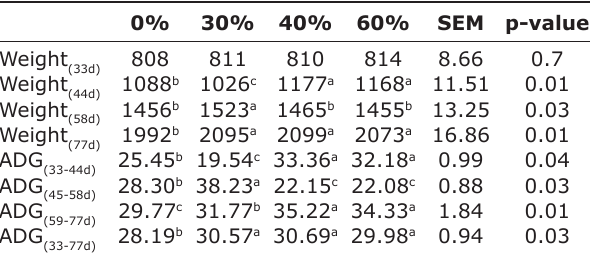
Table-4: Evolution of weight growth (g) and ADG (g/d) during fattening of bunnies as a function of the percentage of incorporation of the DAKM and DTP complex.